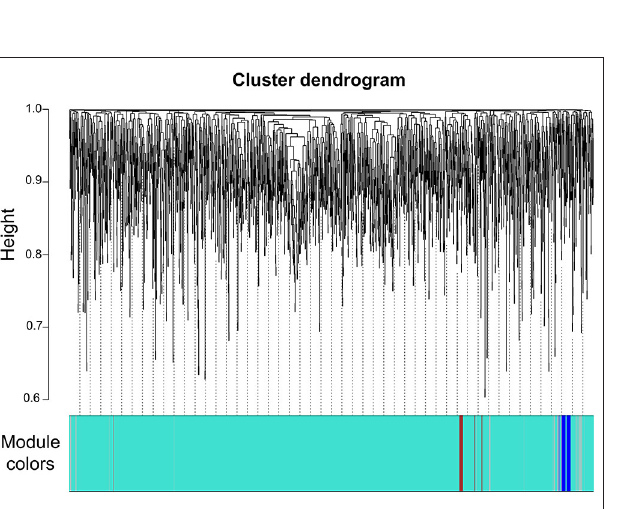
FIGURE 4 | Sample cluster dendrogram. Hierarchical clustering of samples of 1,867 genes in the mouse whole brain.